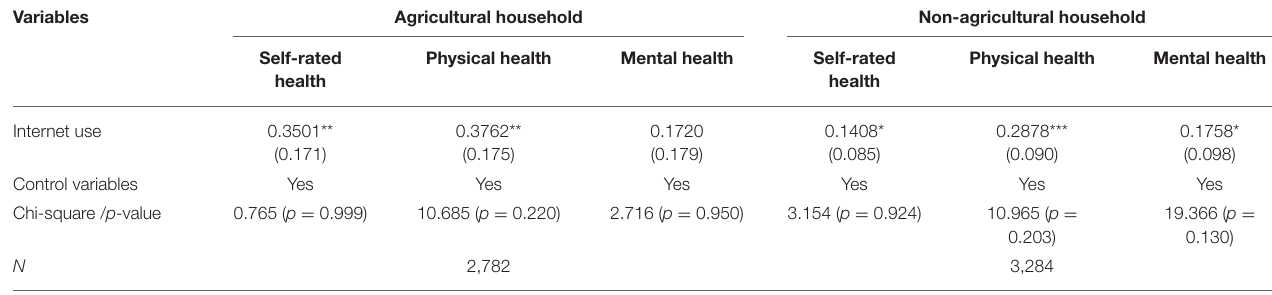
TABLE 7 | Regression results by household.